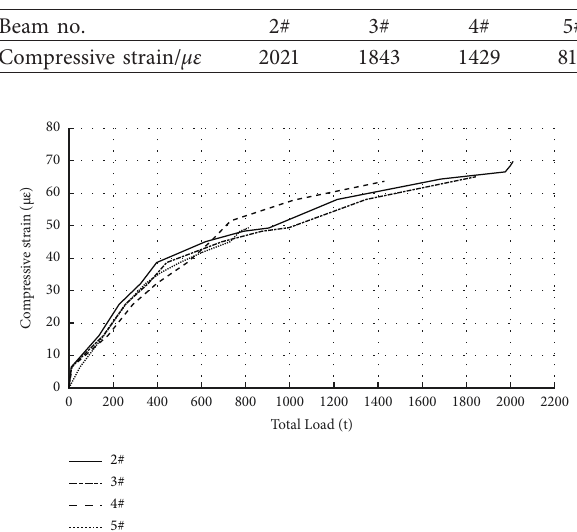
Figure 14: Strain distribution of typical beam section (tension